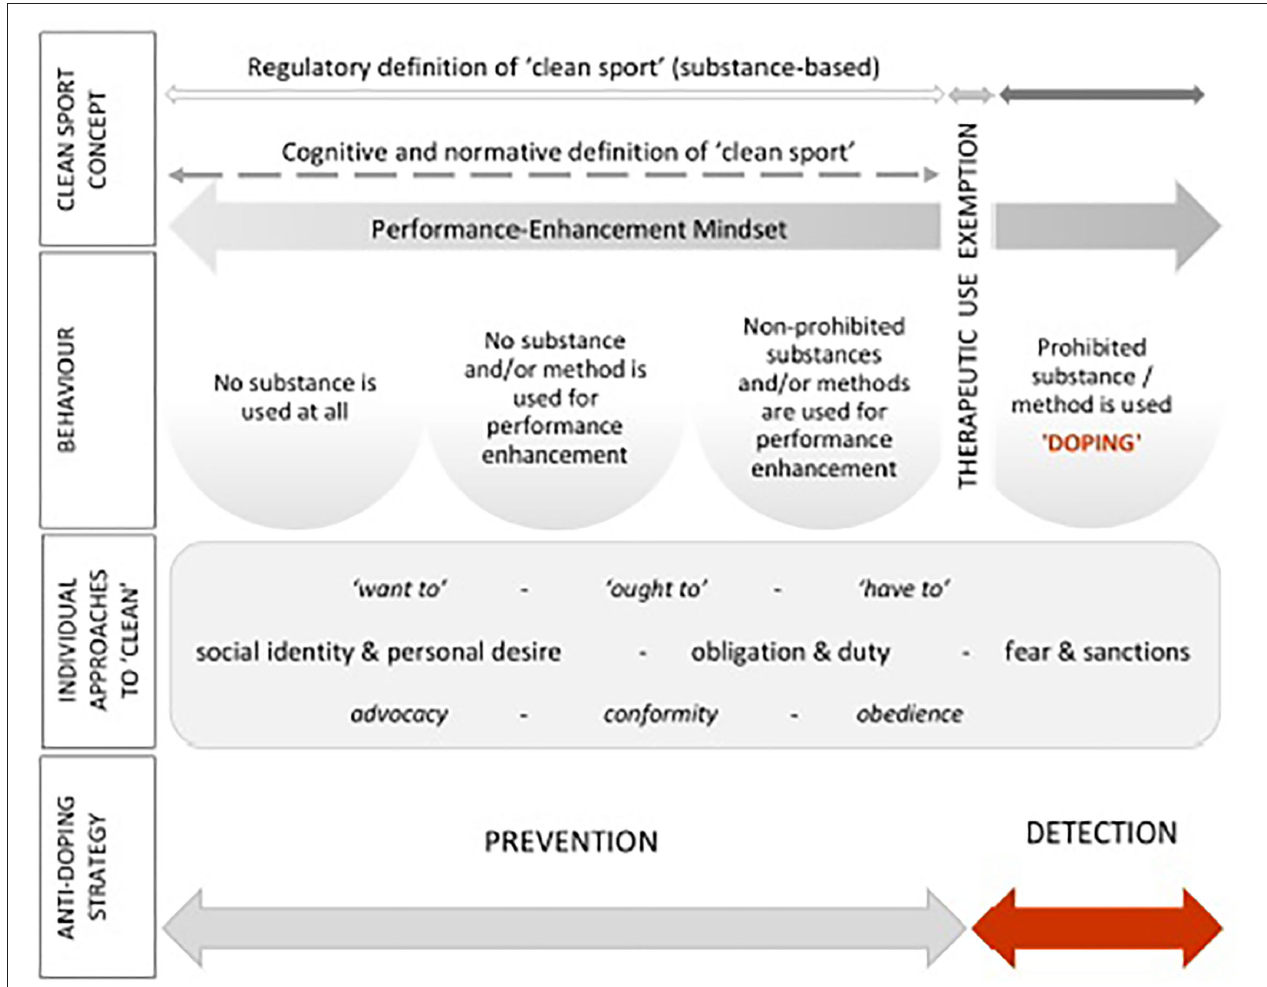
FIGURE 1 | Regulatory, normative, and social cognitive context of performance enhancement and dean sport behavior.